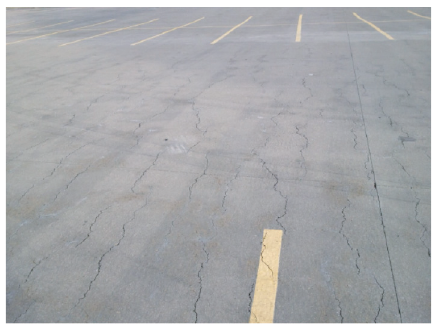
Figure 2: Plastic shrinkage cracking [12].